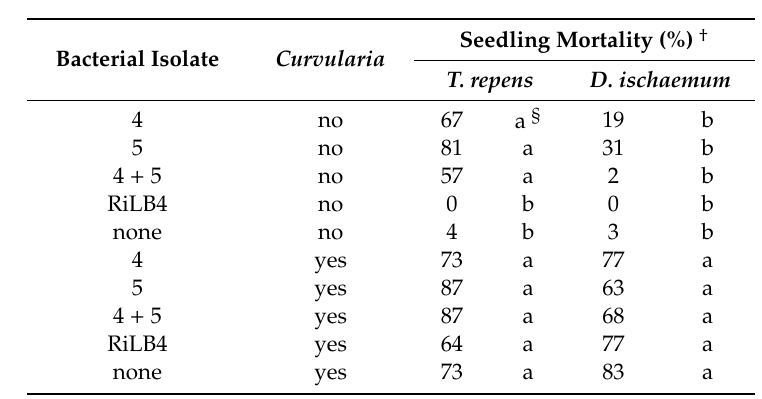
Table 4. E ff ect of Pantoea ananatis isolates 4 and 5 alone and in combination with Curvularia sp. spores outgrowing from surface-sterilized Digitaria ischaemum seeds on Trifolium repens seedling mortality 14 days after inoculation in axenic agarose culture. Ten seeds were placed in each Petri dish and each treatment was replicated in three Petri dishes per experimental run. Combined results of two experimental runs are presented. A Pantoea sp. (RiLB4; Genbank No. KX752781) isolated from Phragmites australis and was included as a standard.